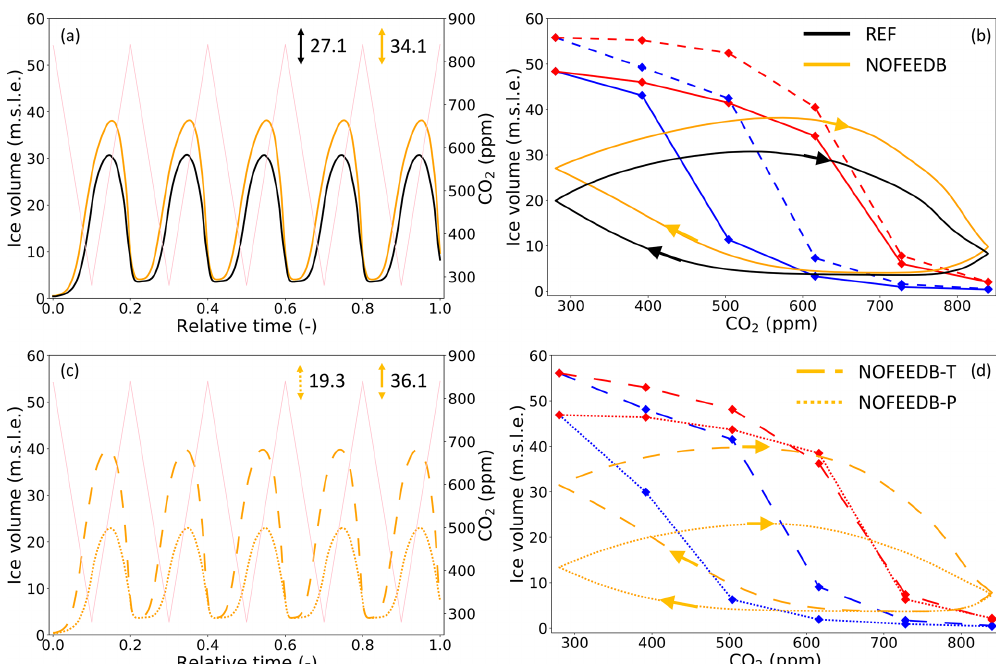
Figure 3. (a) Evolution of forcing CO 2 levels (pink) and ice volume over relative time for the transient 40kyr REF (black) and NOFEEDB (orange) simulations. (b) Relation between CO 2 and equilibrium ice volume (REF, solid red and blue; NOFEEDB, dashed red and blue) and transient ice volume (as in a ). Only the equilibrium cycle (final 40kyr) is shown. (c, d) Same for the NOFEEDB-P (dotted red, blue, and orange) and NOFEEDB-T (long-dashed red, blue, and orange) equilibrium and transient 40kyr simulations. The amplitudes of transient ice volume variability (in ms.l.e.) in the equilibrium cycle are indicated in panels (a) and (c) .